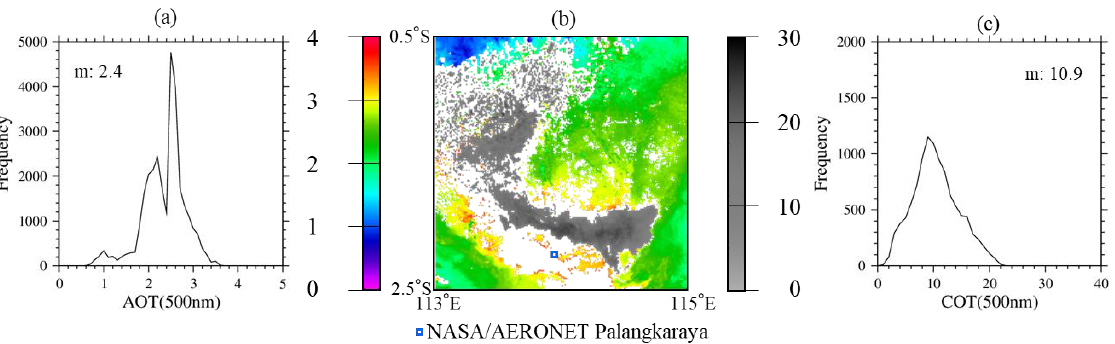
Figure 11. Values of aerosol optical thickness (AOT (500 nm)) (a) and cloud optical thickness (COT (500 nm)) (c) from the JAXA/second-generation global imager (SGLI)/L2 version-1 around the central area of the NASA/AERONET station of Palangkaraya obtained on 15 September 2019. The distribution of AOT (500 nm) and COT (500nm) is shown in the color scale and gray scale, respectively, in (b).